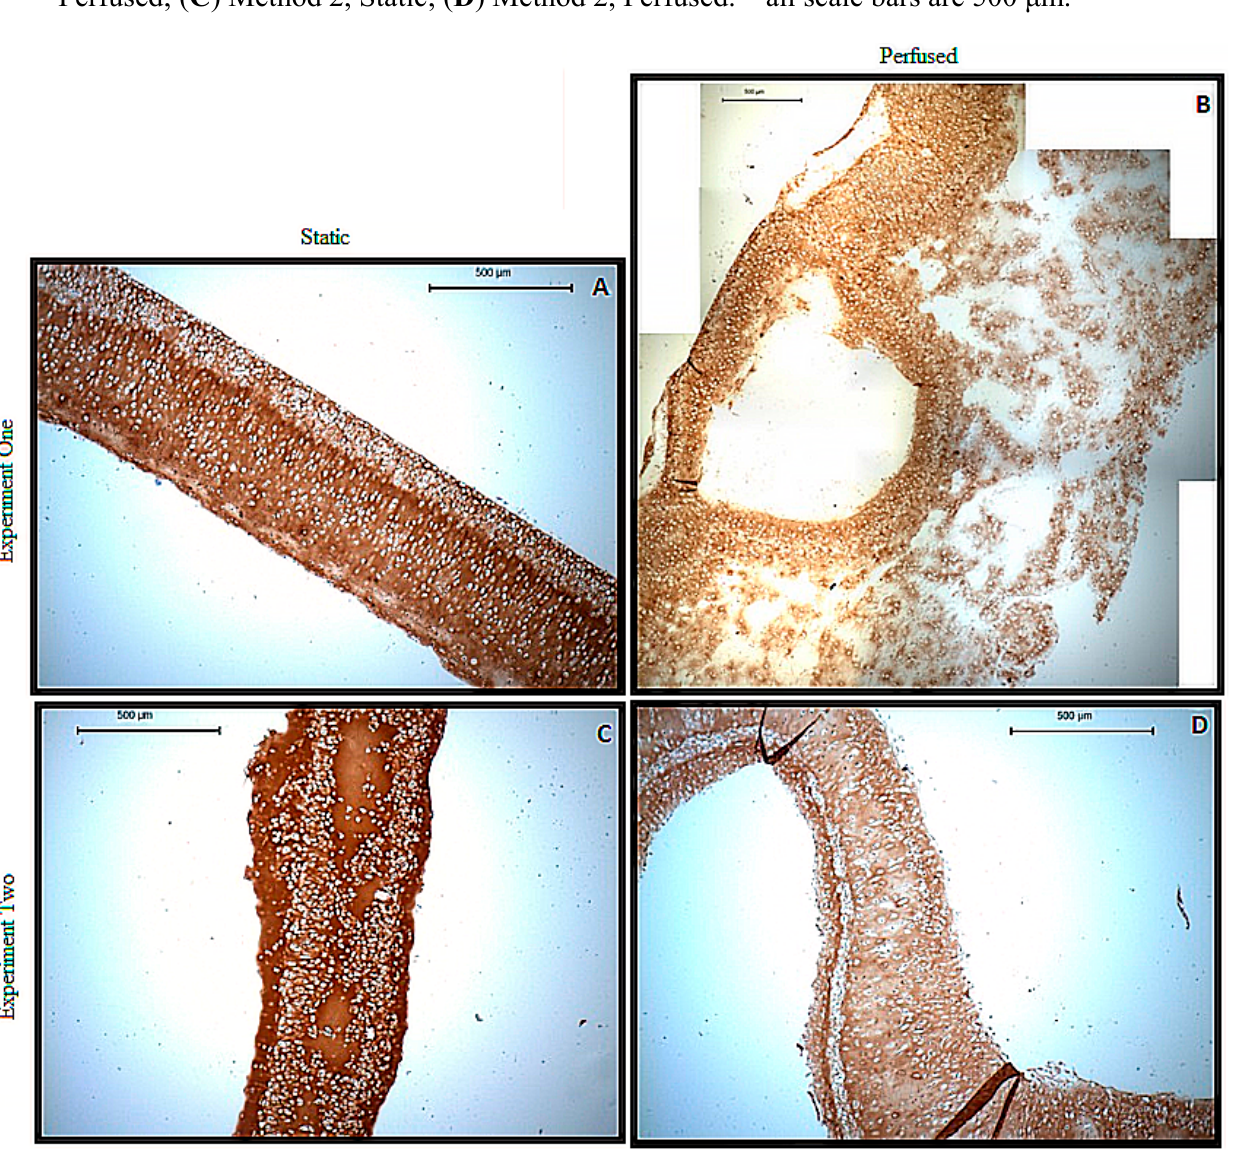
Figure 6. Type II collagen histology from Methods 1 and 2. ( A ) Method 1, Static; ( B ) Method 1, Perfused; ( C ) Method 2, Static; ( D ) Method 2, Perfused. * all scale bars are 500